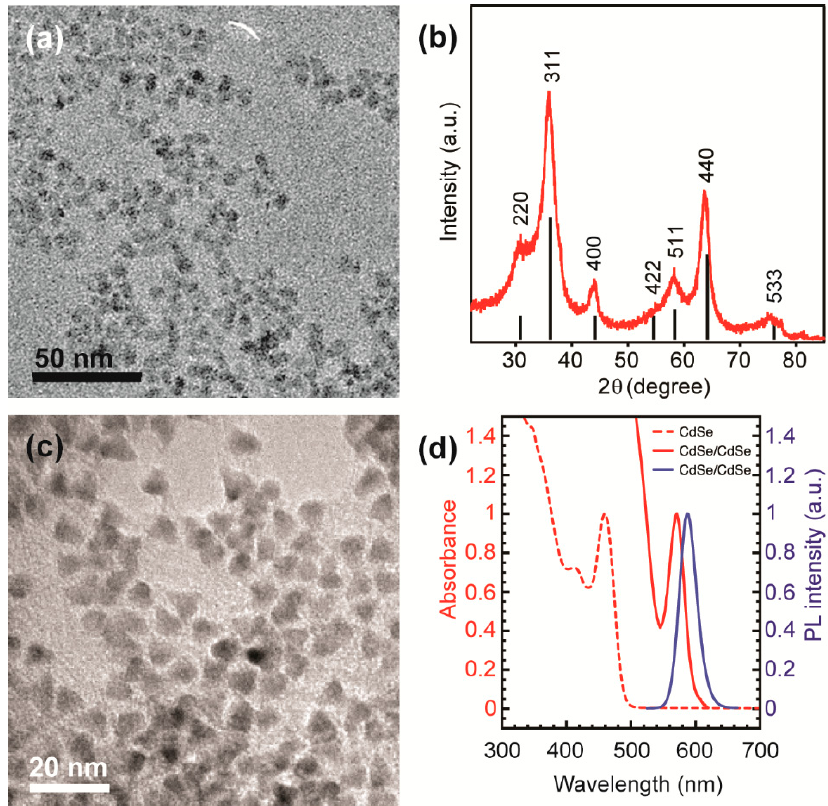
Figure 1. ( a ) Overview transmission electron microscopy (TEM) image of colloidal γ -Ga 2 O 3 nanocrystals (NCs) having an average dimeter of ca . 5.5 nm; ( b ) X-ray diffraction (XRD) pattern of the same NCs; vertical black lines represent a reference XRD pattern of bulk γ -phase Ga 2 O 3 ; ( c ) Overview TEM image of ca . 6.8 nm CdSe/CdS core/shell NCs; ( d ) Absorption (red) and photoluminescence (PL) (blue) spectra of CdSe/CdS NCs (solid lines), and the absorption spectrum of the corresponding CdSe NC cores (red dashed line).